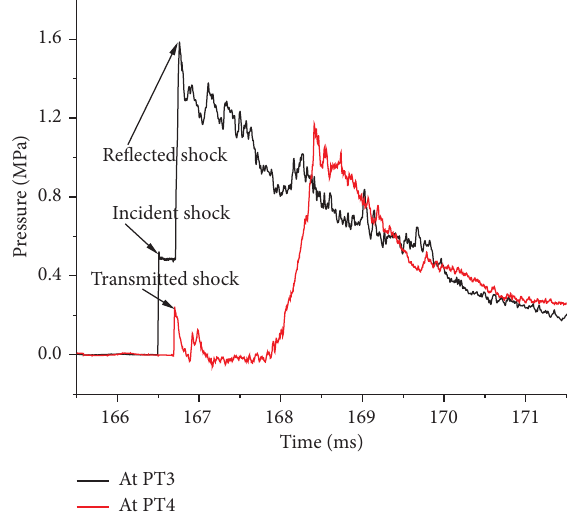
Figure 3: Typical high-speed schlieren images ( I , R , and T denote incident, reflected, and transmitted shock wave; UF and DF denote upstream and downstream front of particles; PC denotes fixed thin- walled carrier of packed